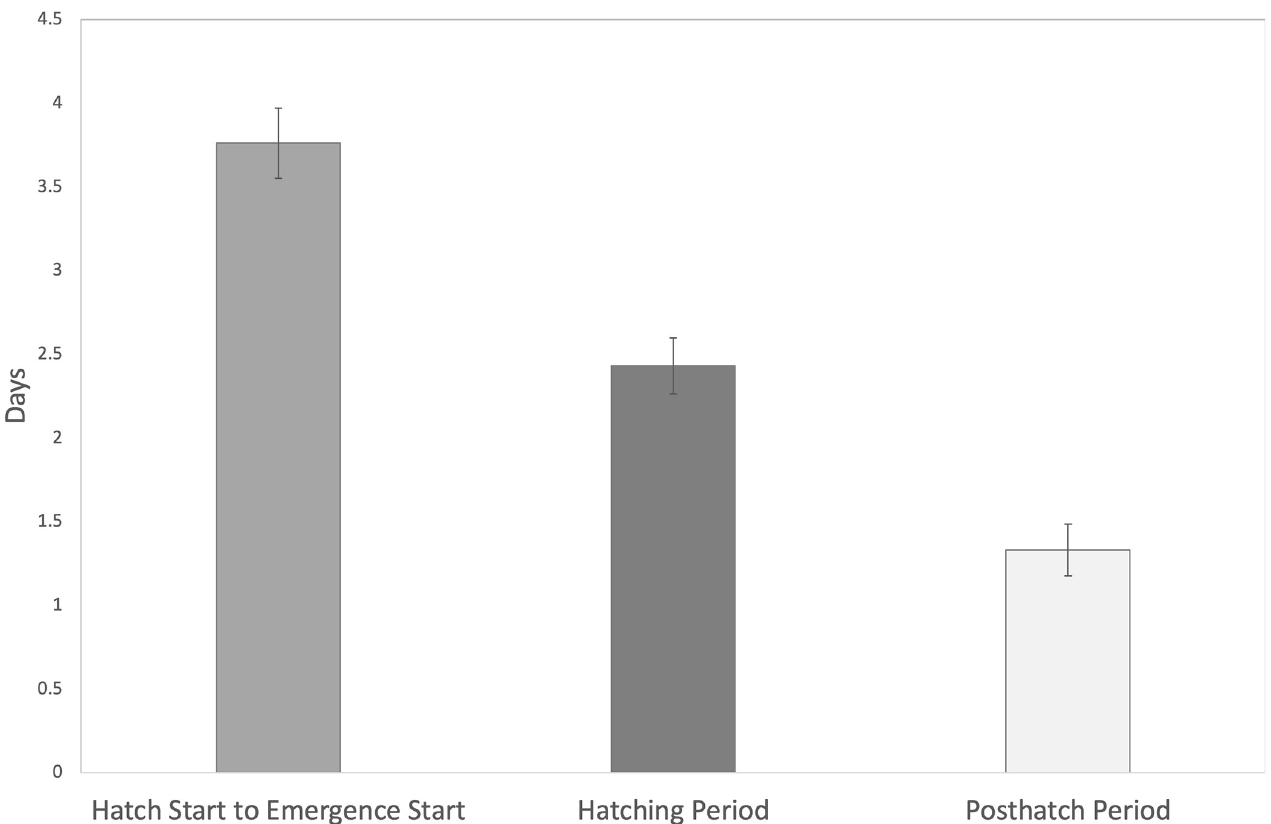
Fig 3. Timing of hatching and post-hatch phases in sea turtle nests. Emergence onto the sand is initiated in Caretta caretta nests 3.62 days +/- 0.23 day (n = 43) after the start of hatching from the eggs, calculated from the combined duration of the hatch and posthatch phases. The minimum wait time between the start of hatching and first emergence was 1.8 days and the maximum was 7.5 days. Hatching lasts an average of 2.21 days +/- 0.18 days ()n = 43) and the posthatch period lasts for an average of 1.46 days +/- 0.18 days (n = 43). Error bars are SEM.